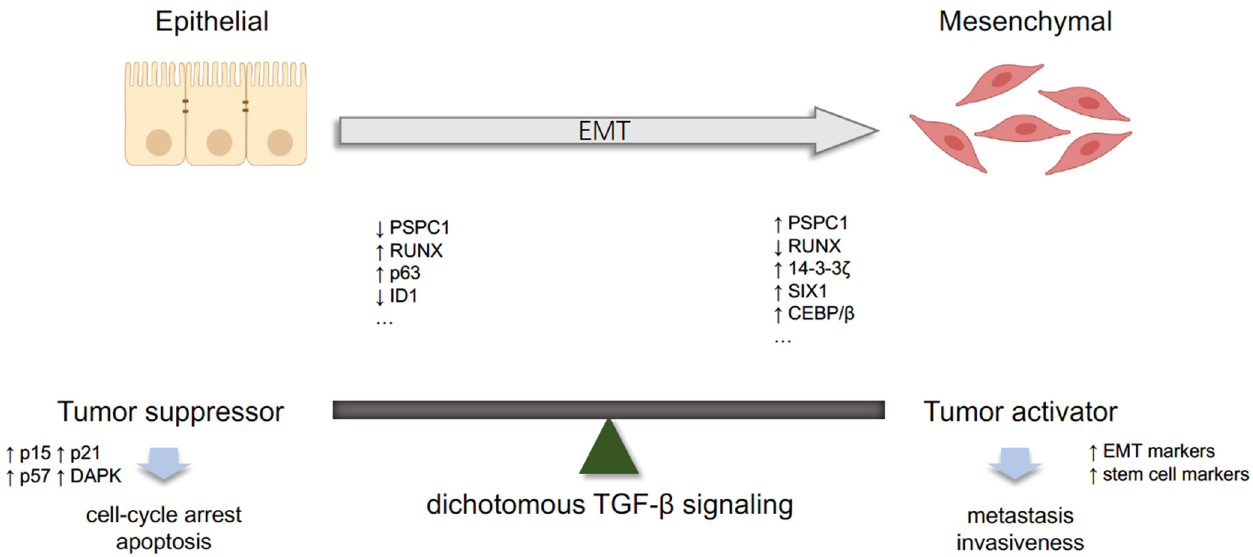
Figure 1. Dichotomous transforming growth factor beta (TGF- β ) signaling pathway. In normal cells or early malignant cells, TGF- β works as a tumor suppressor. Downregulation of PSPC1 [99], RUNX [98], p63 [55] and ID1 [100] could be associated with cell-cycle arrest and apoptosis. In advanced tumors, TGF- β acts as a tumor activator with upregulation of PSPC1 [99], RUNX [98], 14-3-3 ξ [101], SIX1 [102] and CEBP/ β [103]. Upward arrow represents upregulation of indicated factors and downward arrow represents downregulation of indicated factors.